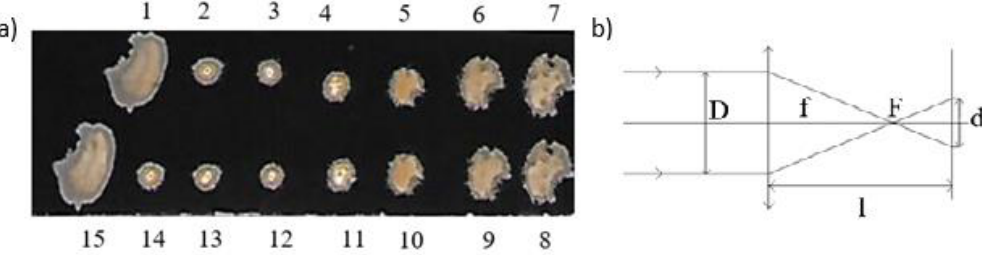
Figure 1. Spots of the focused laser beam on black photocopy paper (3 × magnification) and numeration of the spots ( a ). The scheme for focusing the laser beam ( b ). The symbols in Figure ( b ) denotes: D — the laser beam diameter, F, f — the focal point and the focal length respectively, d — the spot diameter.